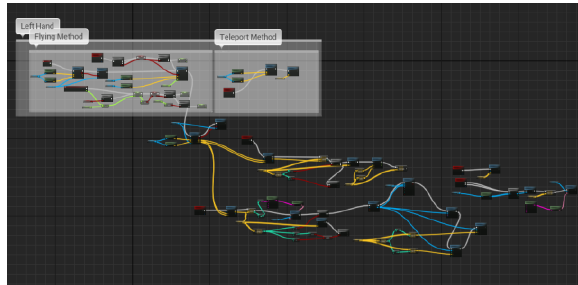
Figure 3. The core coding blueprint of the application. Every separate function that was coded and used has its own blueprint